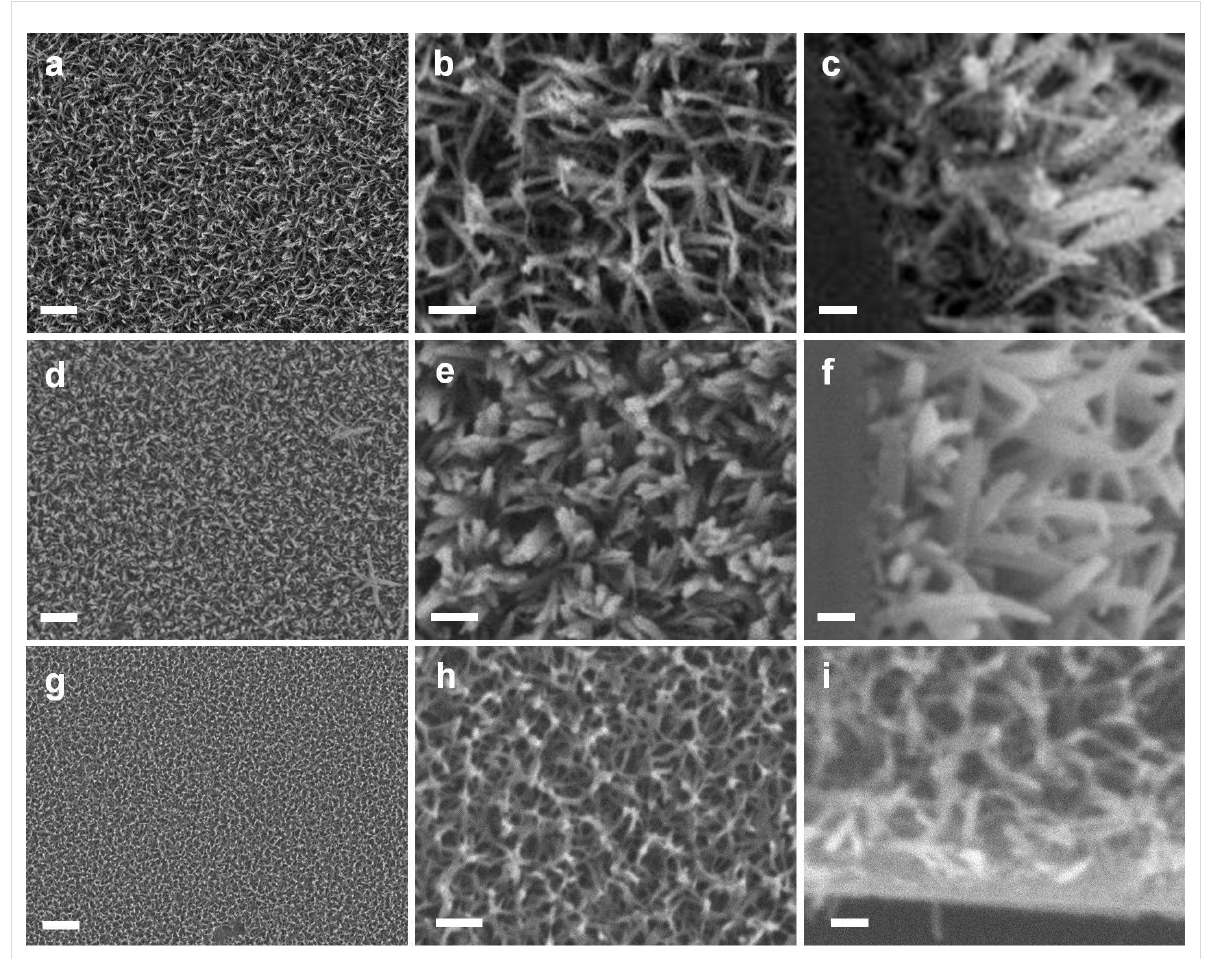
Figure 6: SEM images of LPEI@silica nanograss formed by using methanol as additive to control the LPEI self-assembly on the substrate surface. The self-assembled LPEI matrix was prepared from 4.0 wt % LPEI solutions in pure water (a–c) and in a mixture of methanol and water with volume ratio of 0.6 mL and 1.4 mL (d–f). The sample of g–i was prepared by a room-temperature process. The 3.0 wt % LPEI solution was prepared by dissolving LPEI into a methanol solution containing 10 vol % water. The tube with the film of LPEI in the methanol–water mixture was kept for 6 min at room temperature for methanol evaporation, leaving behind the self-assembled LPEI matrix. The silica depositions were performed in a mixture of 3 mL MS51 and 3 mL water for 40 min at room temperature for each of the three cases. The scale bars are 2 μ m (a, d and g), 500 nm (b, e and h), 200 nm (c, f and